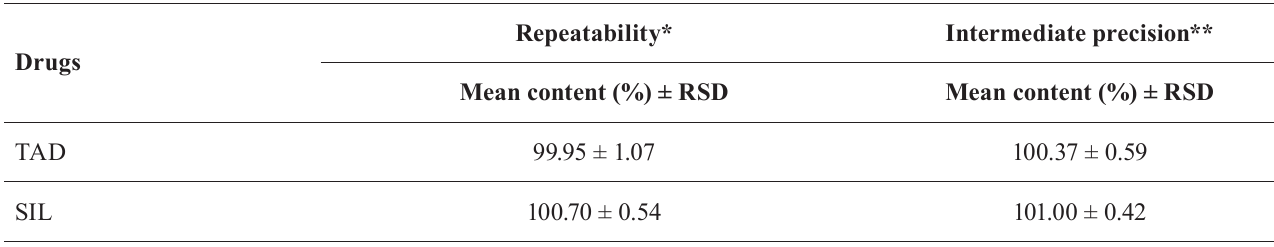
TABLE IV - Values obtained for repeatability and intermediate precision